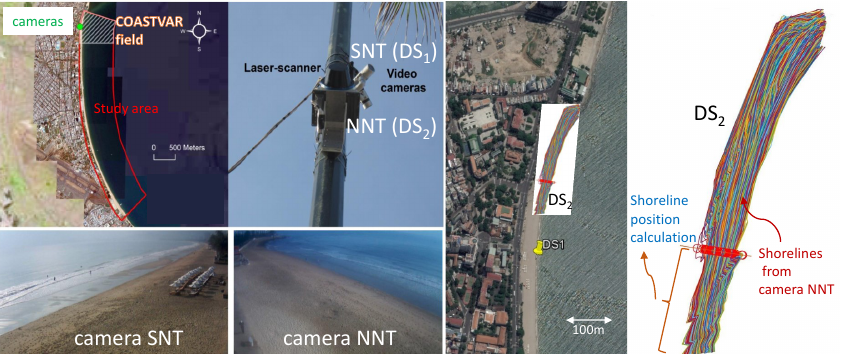
Figure 3. Area of interest (COASTVAR field experiment location) with the location of video cameras and shoreline detection by video